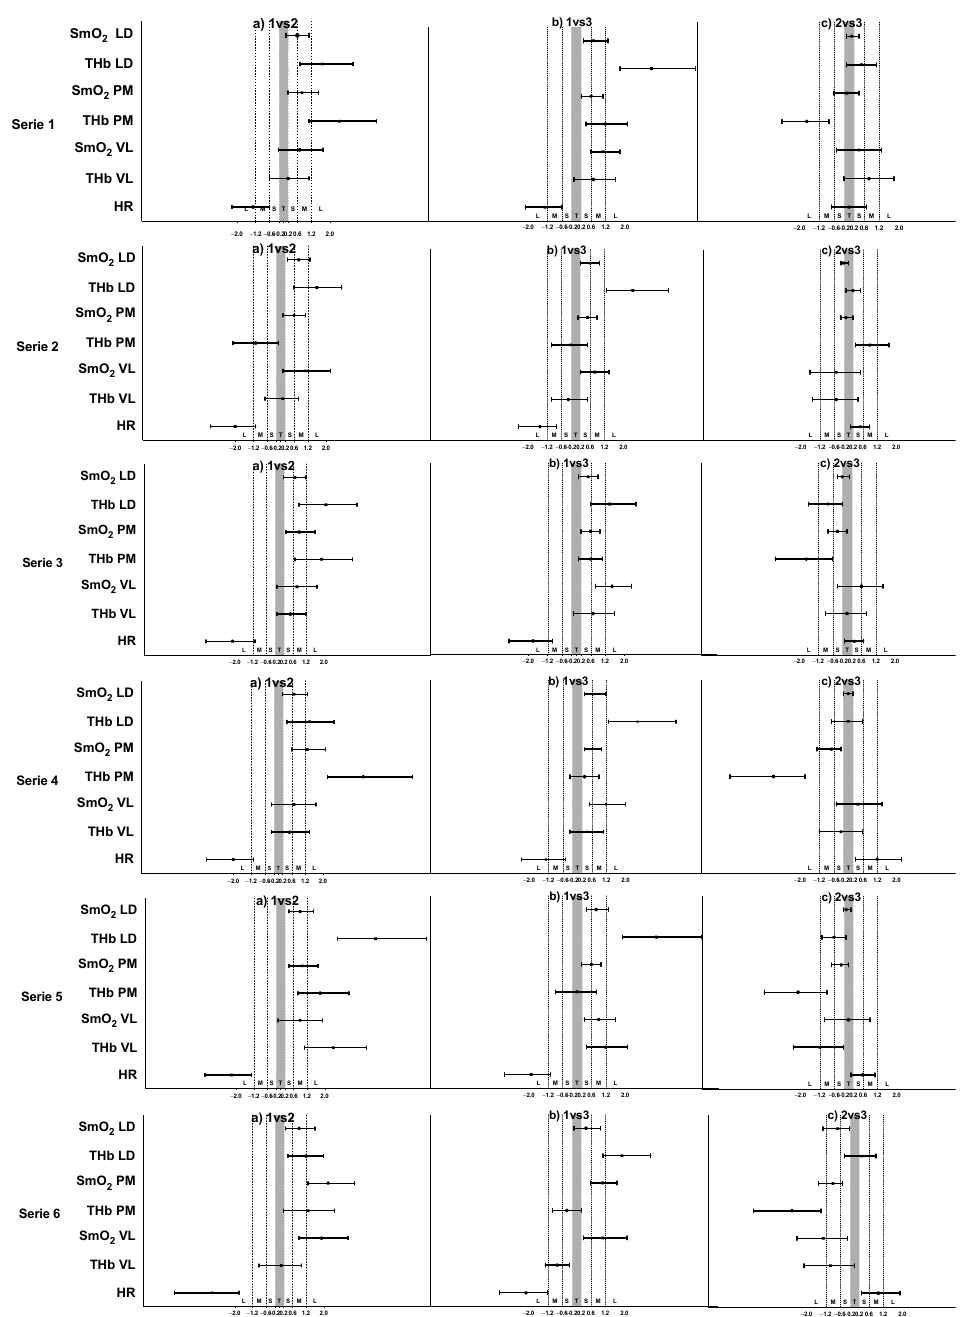
Figure 3. Standardized (Cohen) differences in the considered variables during rest bouts. Error bars indicate uncertainty in the true mean changes with 95% confidence intervals. Abbreviations: 1—RT protocol 1; 3—IT protocol 2; SIT protocol 3; SmO 2 —muscle oxygen saturation; tHb—total hemoglobin; LD—latissimus dorsi; PM—pectoralis major; VL-vastus lateralis; HR—heart rate; T—trivial effect; S—small effect; M—moderate effect; L—large